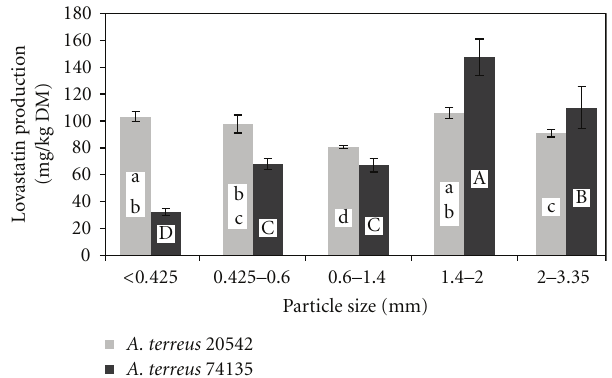
Figure 7: E ff ect of particle size on lovastatin production by two strains of A. terreus ( P < 0 . 01). (a, b, c, and d) indicate di ff erences among means between samples for A. terreus ATCC 20542. (A, B, C, and D) indicate di ff erences among means between samples for A. terreus ATCC 20542.